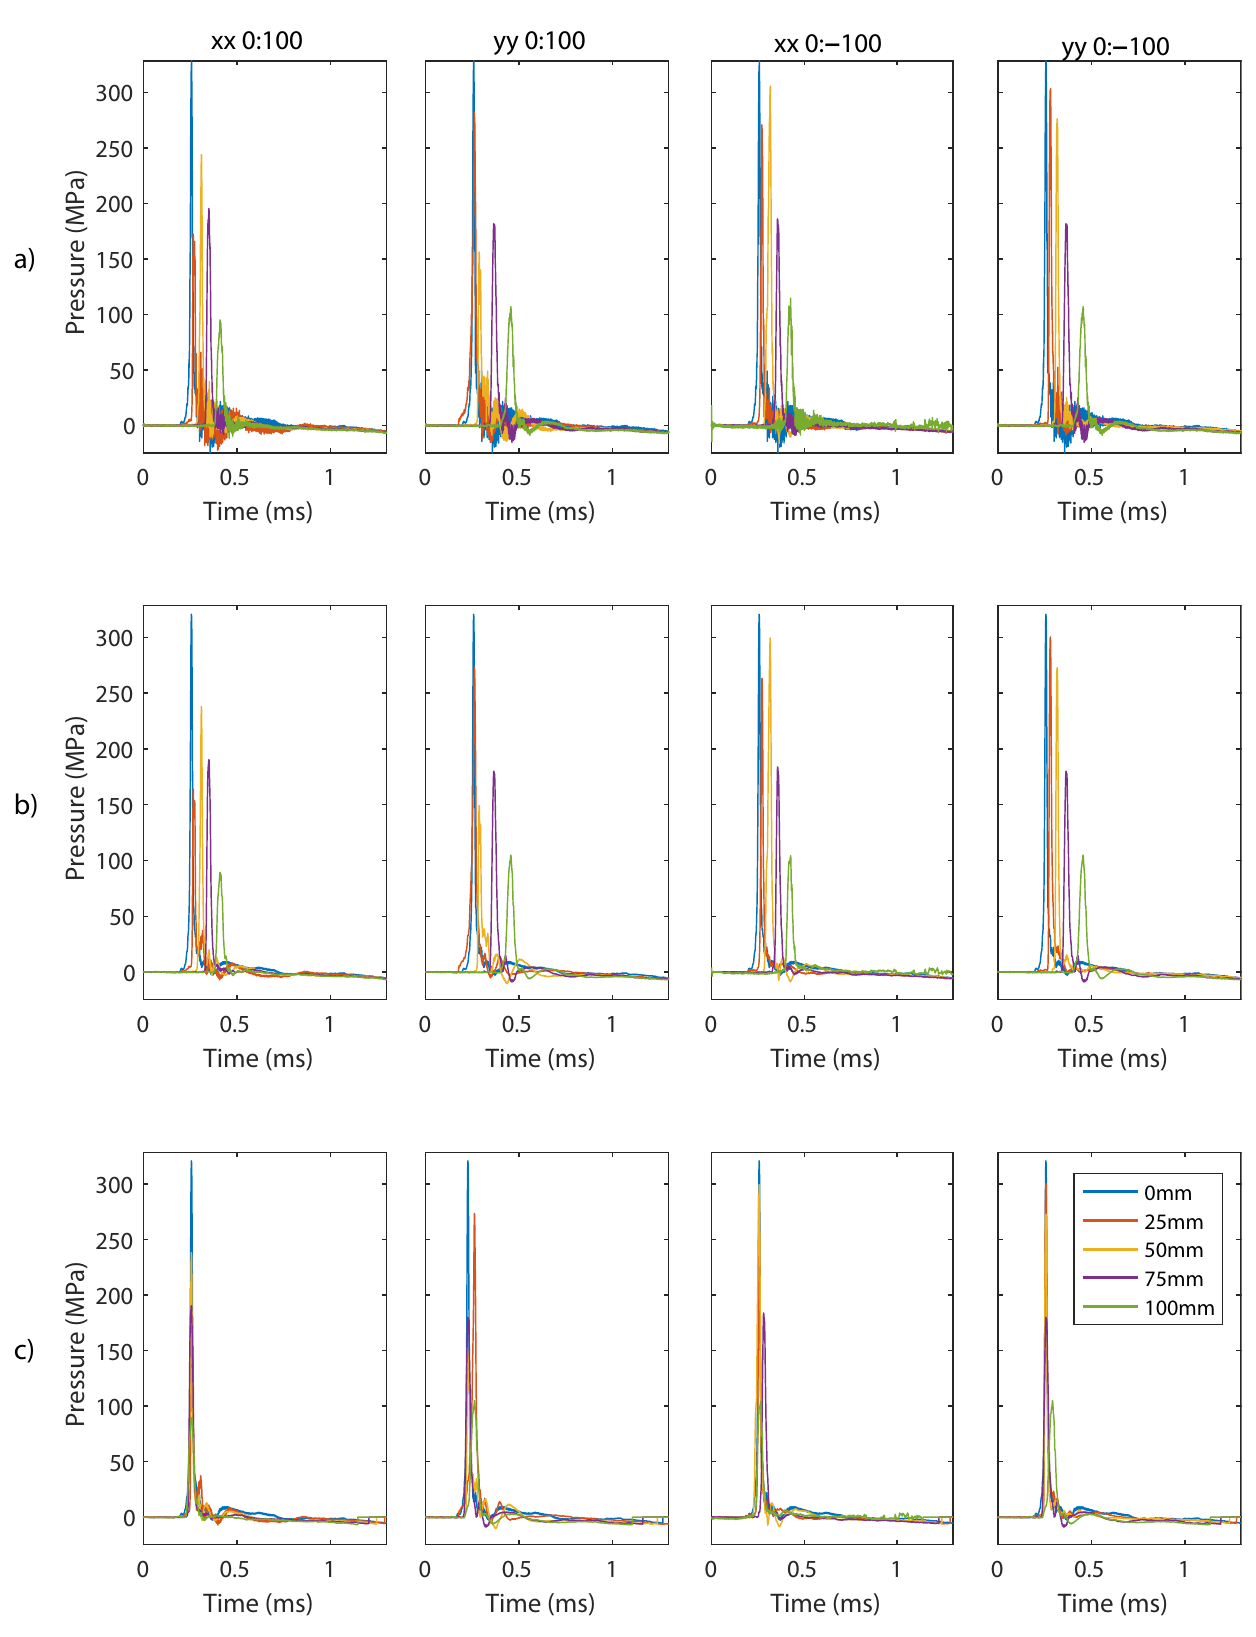
Figure 8. Full array of pressure signals for a single test: ( a ) raw pressure input, ( b ) smoothed, and ( c )